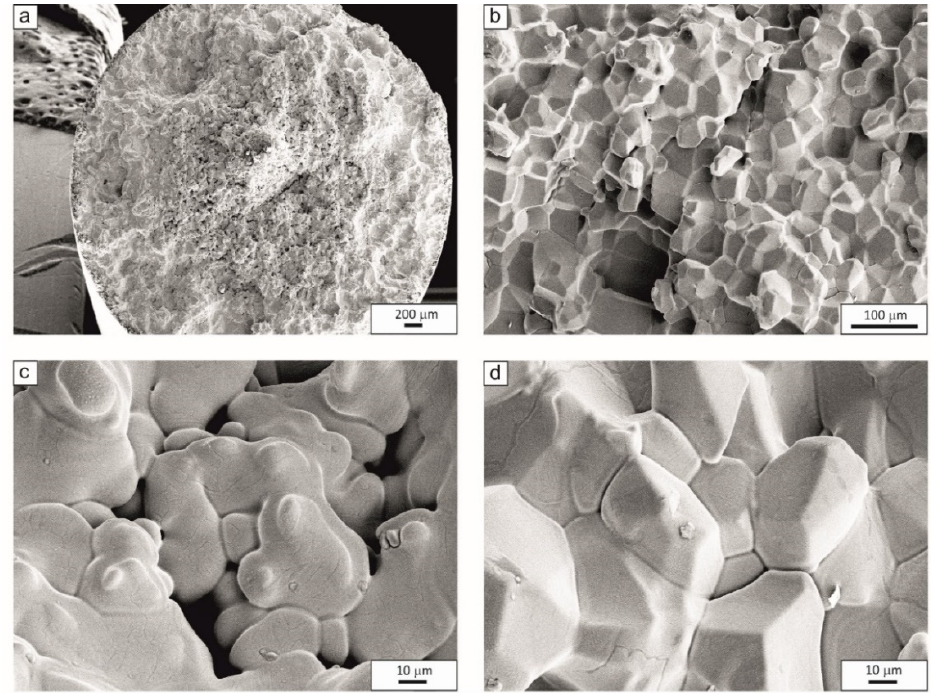
Figure 6. Fracture surfaces of samples of 27Mn-4Si-2Al-Nb steel after cracking at NST 2 = 1250 °C. ( a ) brittle fracture, ( b ) intercrystalline fracture area, ( c , d ) melted grain boundaries.